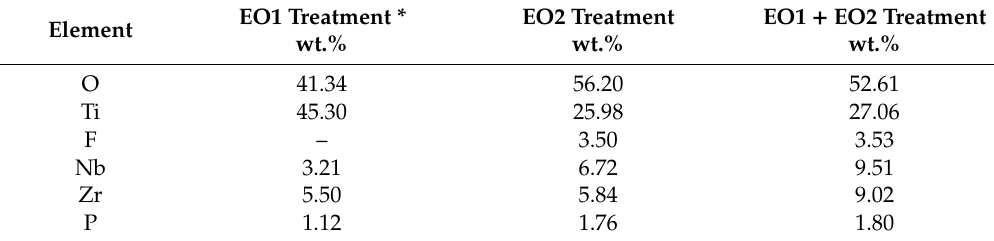
Table 3. EDS examinations of tested specimens.